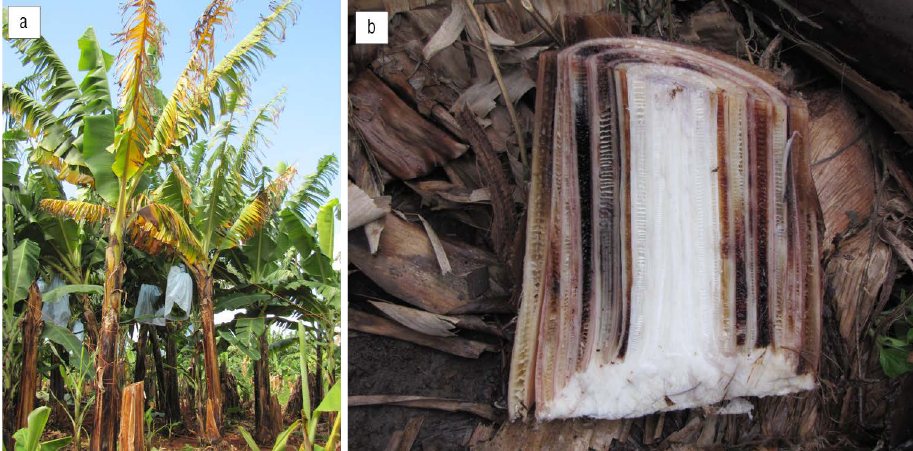
Symptoms of banana Fusarium wilt at Metocheria farm, northern Mozambique: (a) external symptoms of leaf yellowing, progressing from the older to younger leaves, and (b) internal symptoms of reddish-brown discoloration of vascular tissue in the